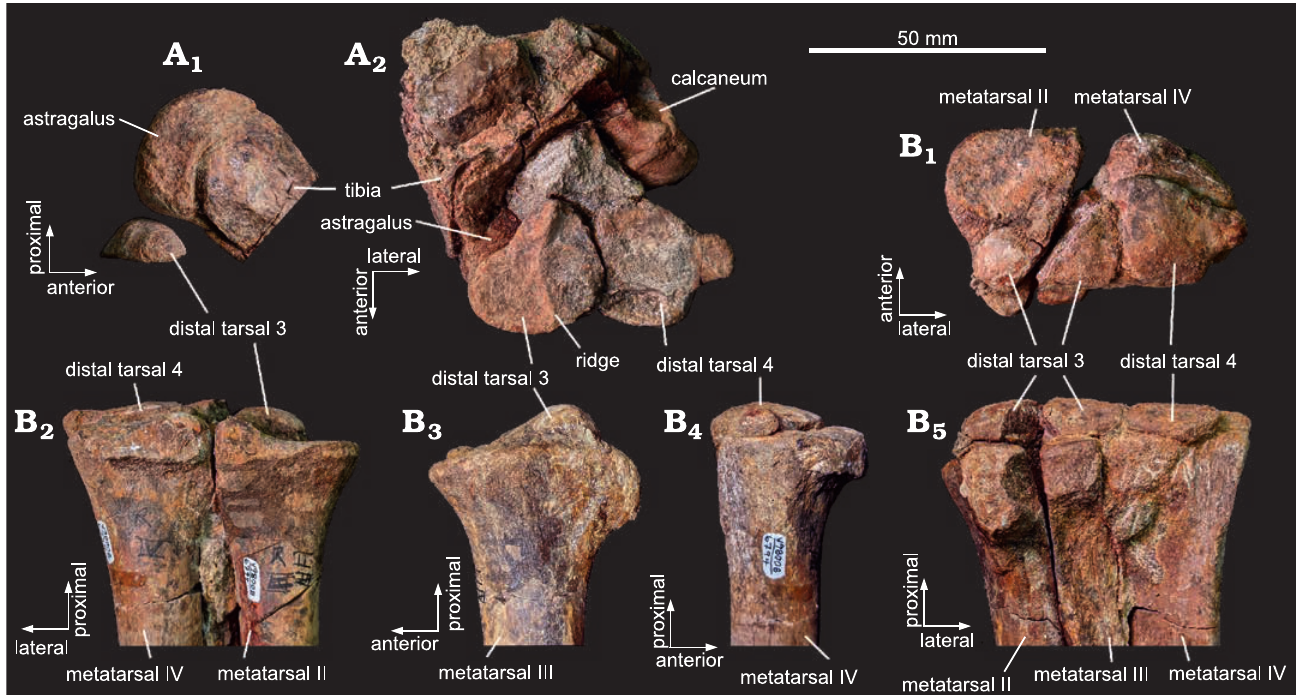
Fig. 1. Tarsal region of Ornithomimidae indet., RAM 6794 from upper Campanian Kaiparowits Formation, Utah, USA, as preserved in articulation. A . Left tarsus, tibia, proximal tarsal region, and distal tarsals in lateral view (A 1 ); distal tarsals in distal view and tibia, astragalus, and calcaneum in oblique anterior view (A 2 ). B . Right tarsus, metatarsals and distal tarsals in proximal (B 1 ), anterior (B 2 ), medial (B 3 ), lateral (B 4 ), and posterior (B 5 ),